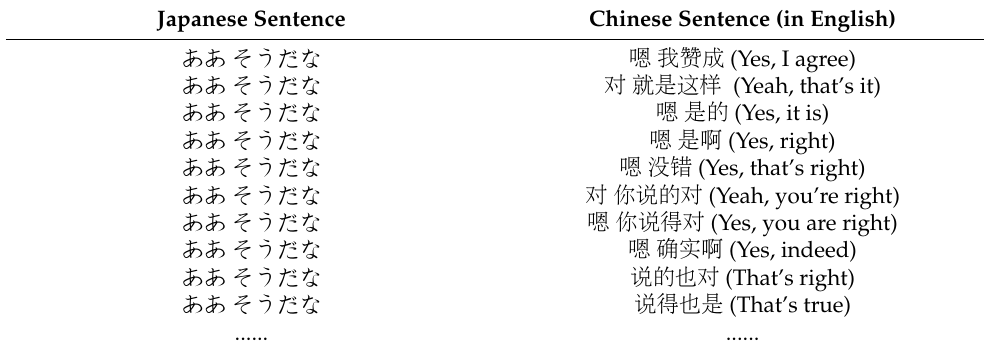
Table 9. Examples of one-to-many translations.